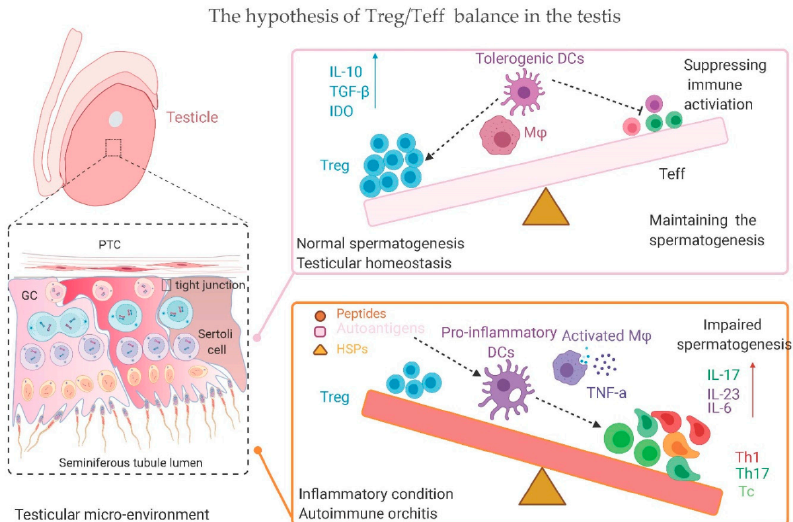
Figure 1. Balance between Treg cells and Teff cells in the testes. Under normal conditions, Tregs could effectively control Teff cells through several immunosuppressive mechanisms, and a balance between them could instrumentally sustain and foster normal spermatogenesis and testicular homeostasis. However, Treg cells are outnumbered by vigorously expanding Teff cells under pathological states, such as testicular chronic inflammation and infection, and the balance between Treg and Teff cells is disturbed, resulting in impaired spermatogenesis, autoimmune orchitis, and/or azoospermia. DC, dendritic cell; HSP, heat shock protein; IL, interleukin; IDO, indoleamine 2,3-dioxygenase; M ϕ , macrophage; Treg, regulatory T cell; Teff, effective T cell; TGF- β , transforming growth factor β ; TNF- α , tumor necrosis factor α ; Upward arrow: detectable increase of cytokine level; Dotted line: proposed communication among